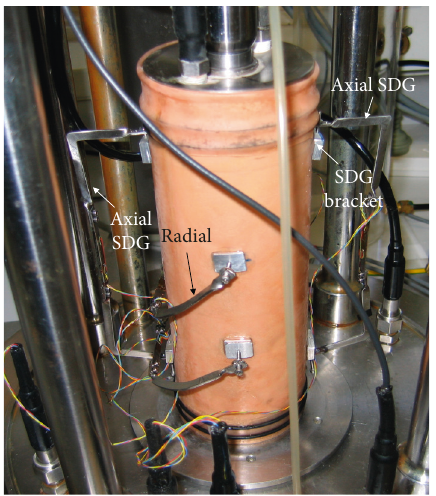
Figure 9: Triaxial specimen in the K